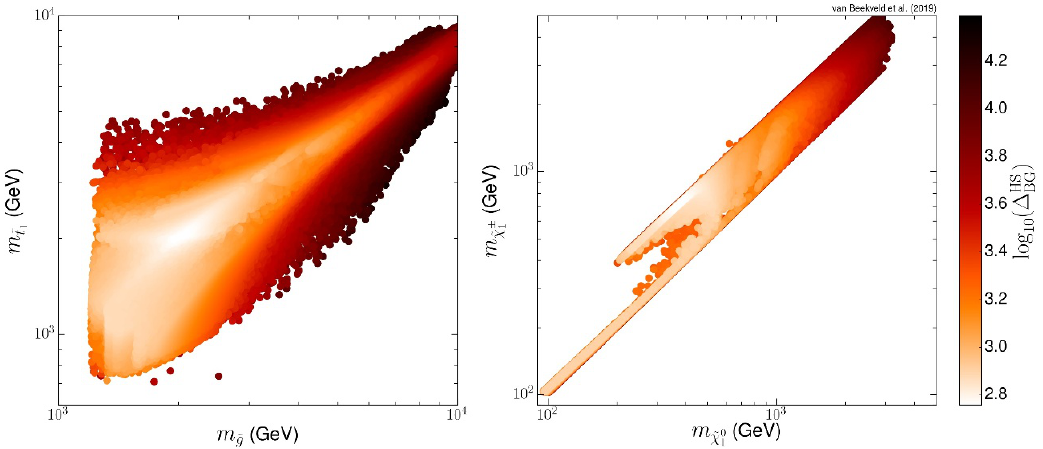
Figure 2 . Left: the gluino mass ( m ~ g ) against the lightest stop mass ( m ~ only the allowed spectra. Right: the lightest chargino mass ( m mass ( m ) for the allowed spectra. All the masses are shown in units of GeV. The color code ~ (cid:31) 0 1 indicates the value for log ((cid:1) HS ). Spectra with lower values for log 10 BG with higher values.